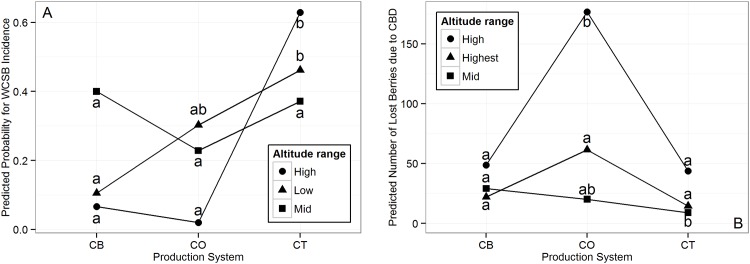
Interaction plots of the least-squares means (back-transformed by inverse-link function to original response scale) based on the fitted models.Effect of coffee production systems on predicted probability of WCSB incidence (A) and predicted number of lost berries due to CBD (B) at different altitude ranges. Production systems with the same letter do not differ significantly (Tukey-type comparisons of glm-parameters, p < 0.05, tested separately for each altitude range). An interaction is given if the difference between coffee systems of one altitude range differs significantly from the difference between coffee systems of another altitude range. CB = Coffee-Banana System, CO = Coffee-Open System, CT = Coffee-Tree System.